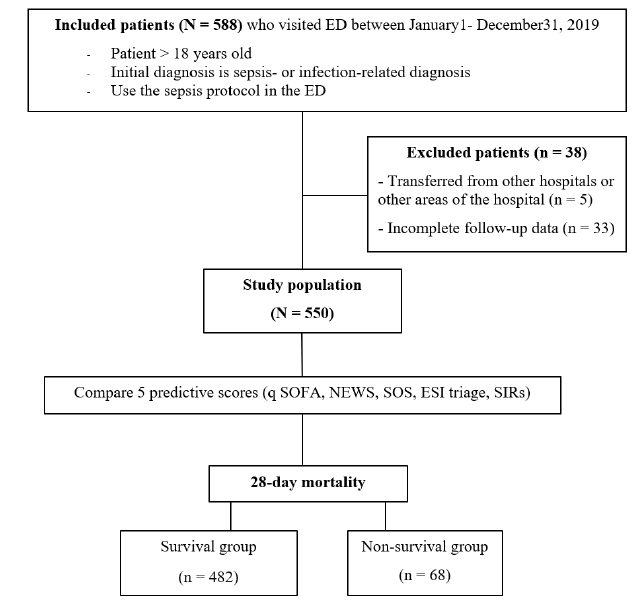
Figure 1. Protocol flow chart for sepsis screening study at emergency department triage.